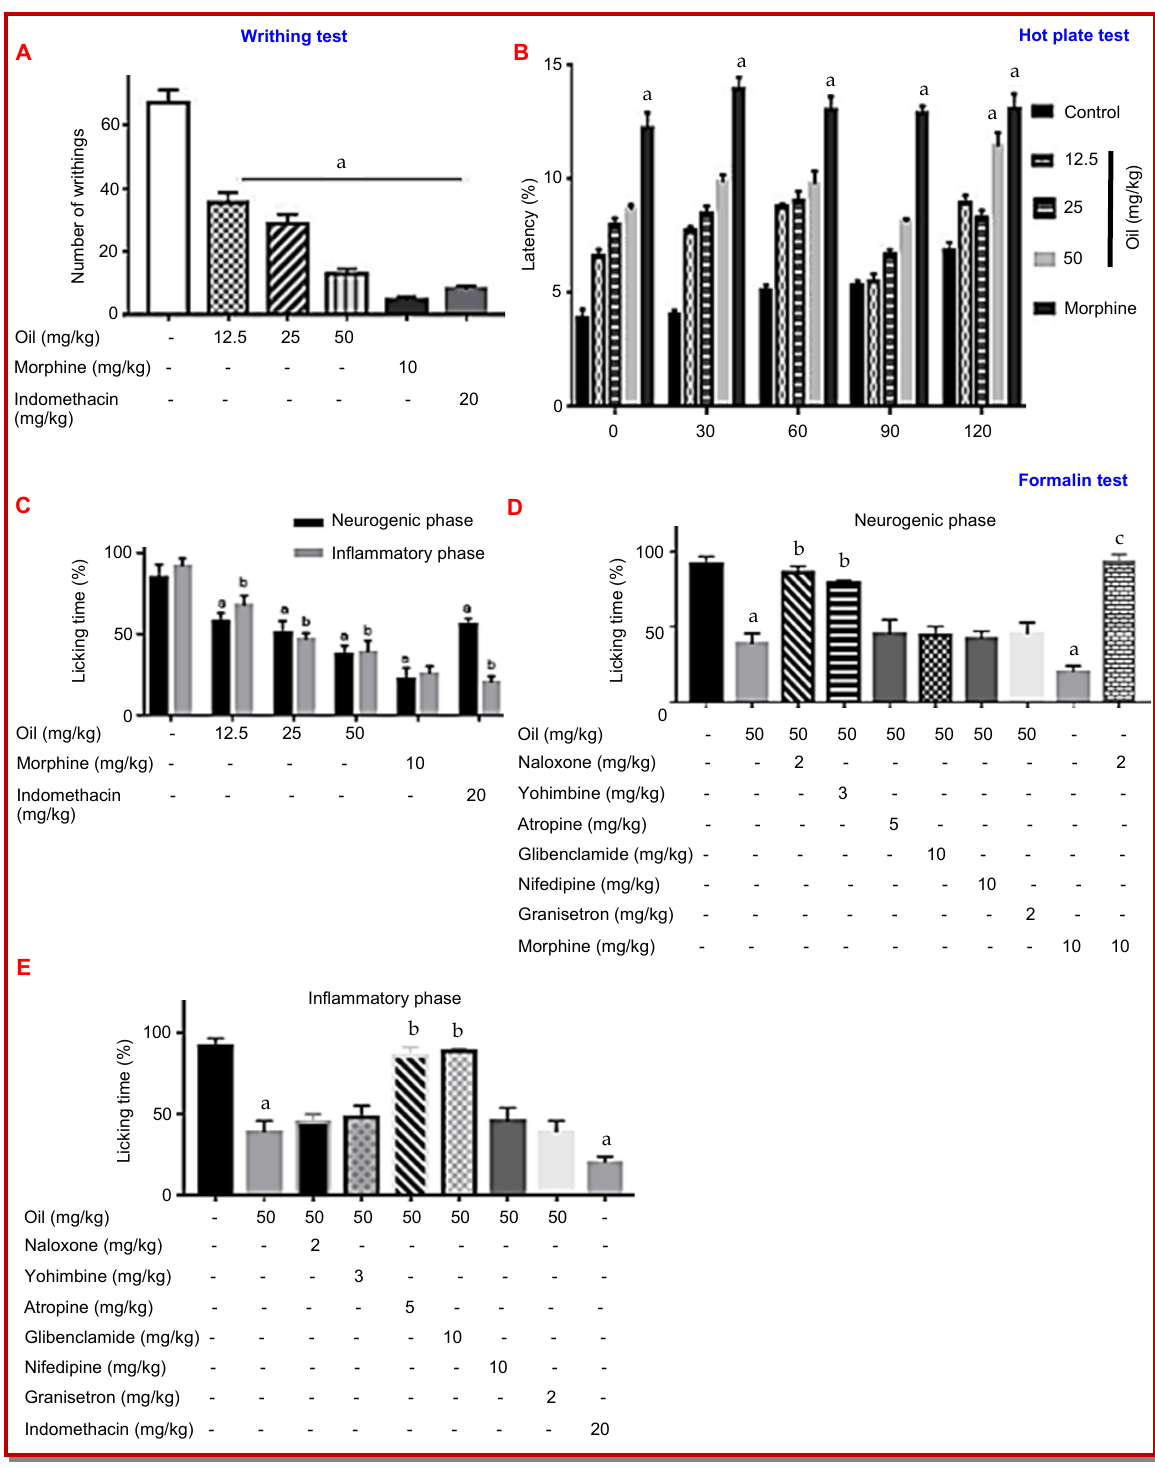
Figure 1: Antinociceptive (A-B) and analgesic (C-E) effects of P. lentiscus essential oil in writhing test, hot plate test and formalin test (neurogenic and inflammatory phases). Data are presented as mean ± SEM. ‘a’ indicates difference between negative control and treated groups, ‘b’ indicates differences between treated group and antagonists. ANOVA one- way followed by Tukey’s post hoc